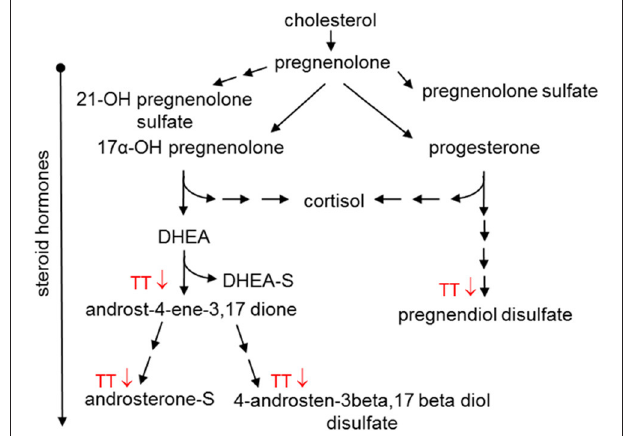
FIGURE 5 | Effect of tocotrienols supplementation on steroid hormone metabolism. Proposed actions of tocotrienols on cholesterol metabolites based on serum analysis from subjects. Tocotrienols tended to result in lower amounts of compounds where the downward arrows are